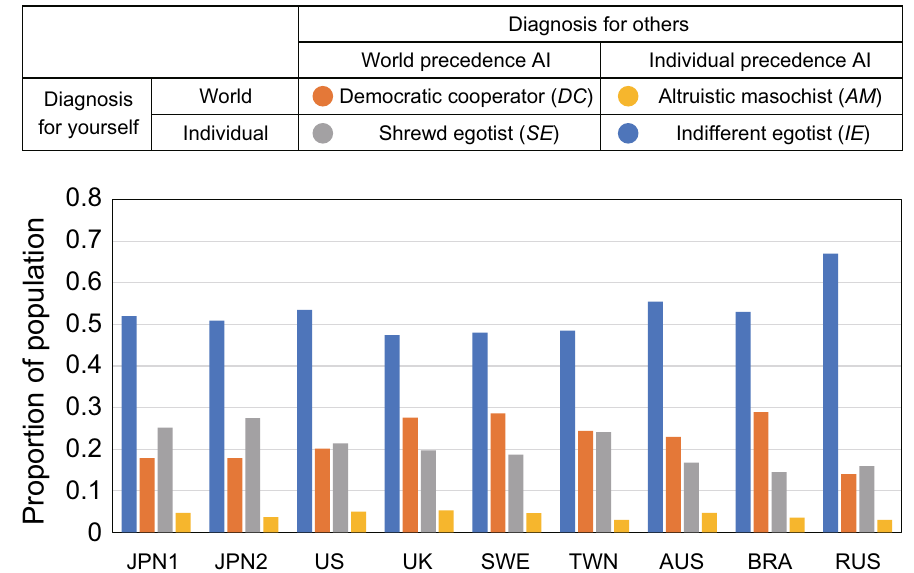
Figure 2. The proportion of the population in each of the four principal categories in each country/area. There are four combinations of answers to which AI you would like to receive a diagnosis from when you or someone else (stranger) becomes sick. The most common answer in all countries/areas was that both they and strangers should be diagnosed by an Individual-AI, IEs (blue). In contrast, people who chose for both themselves and strangers to be diagnosed with World-AI, DCs (orange). SEs (gray) embody the social dilemma in which they want strangers to have a World-AI diagnosis but want an Individual-AI diagnosis for themselves. Those who were tolerant enough to allow strangers to use Individual-AI while they themselves were diagnosed with World-AI, AMs